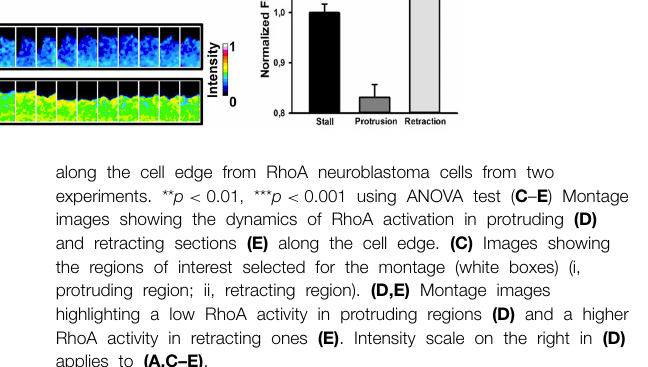
FIGURE 2 | Spontaneous RhoA dynamics in NG108-15 cells. (A) Ratiometric FRET live imaging of a representative RhoA-FRET neuroblastoma cell (n = six experiments). Consecutive frames were taken every second (left: generation of a ratiometric image) for 15min. Insets on the right show a time series (1 frame every 3min) of the magnified region denoted by the white box in the left image. Arrows indicate protrusion and retraction directions. The red line shows the initial edge profile. Scale Bar: 20 µ m. (B) Quantification of mean RhoA activity (FRET ratio) in 50 stalling, protruding and retracting sections